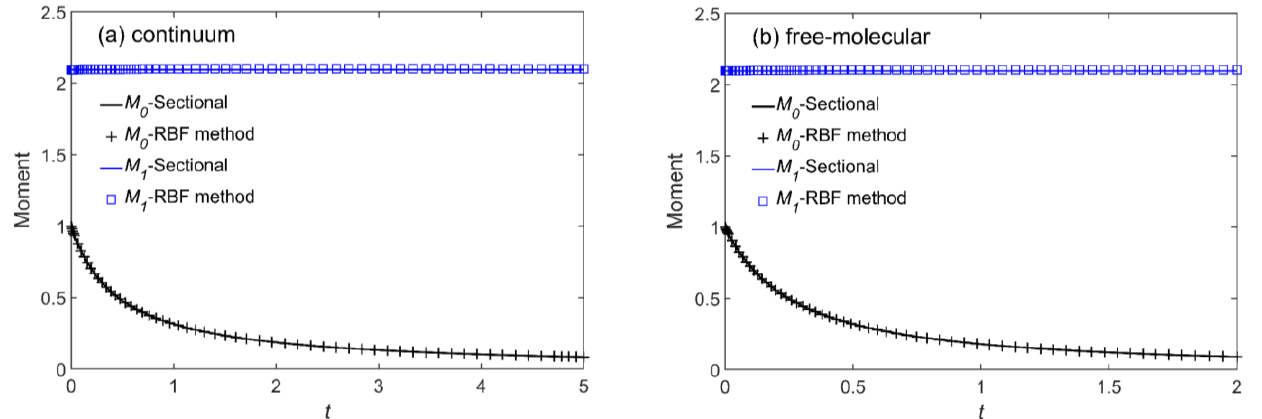
Figure 4. Temporal evolution of the first two moments predicted using the RBF and the sectional methods: ( a ) Brownian coagulation under the continuum regime; ( b ) Brownian coagulation under the free-molecular regime.